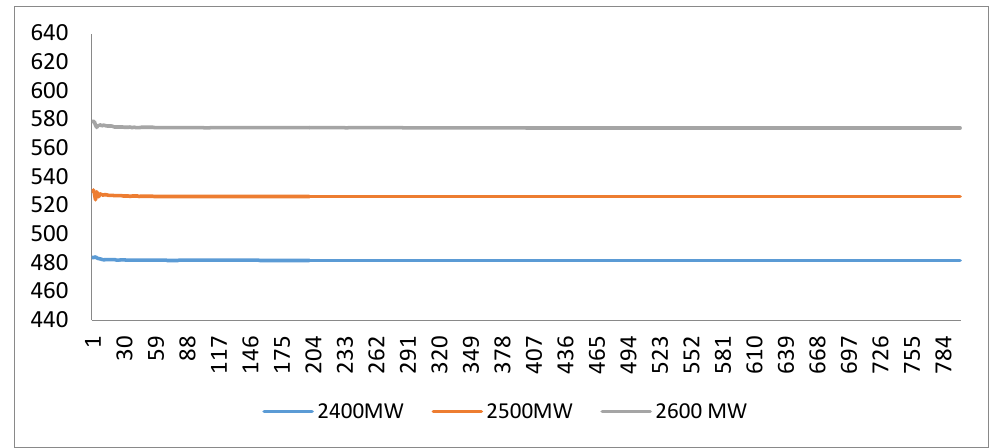
Figure 6. The convergence characteristics of the proposed for system 1 (without valve point loading effects), P d = 2700 MW.